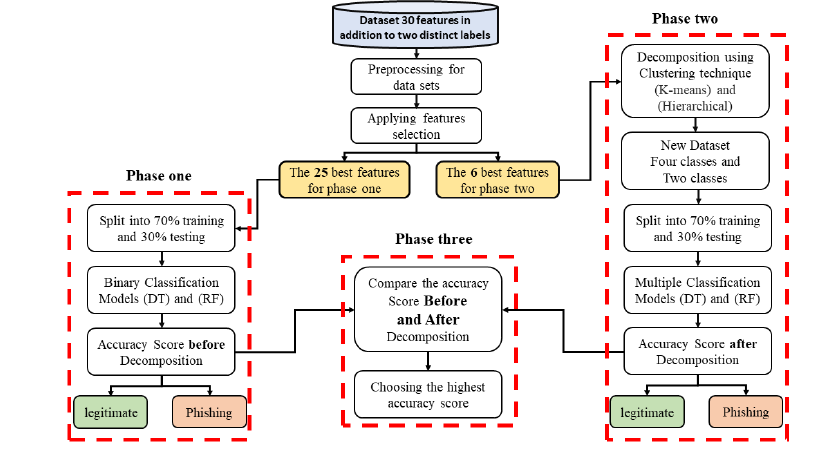
Fig. 4. Theoretical workflow and prediction